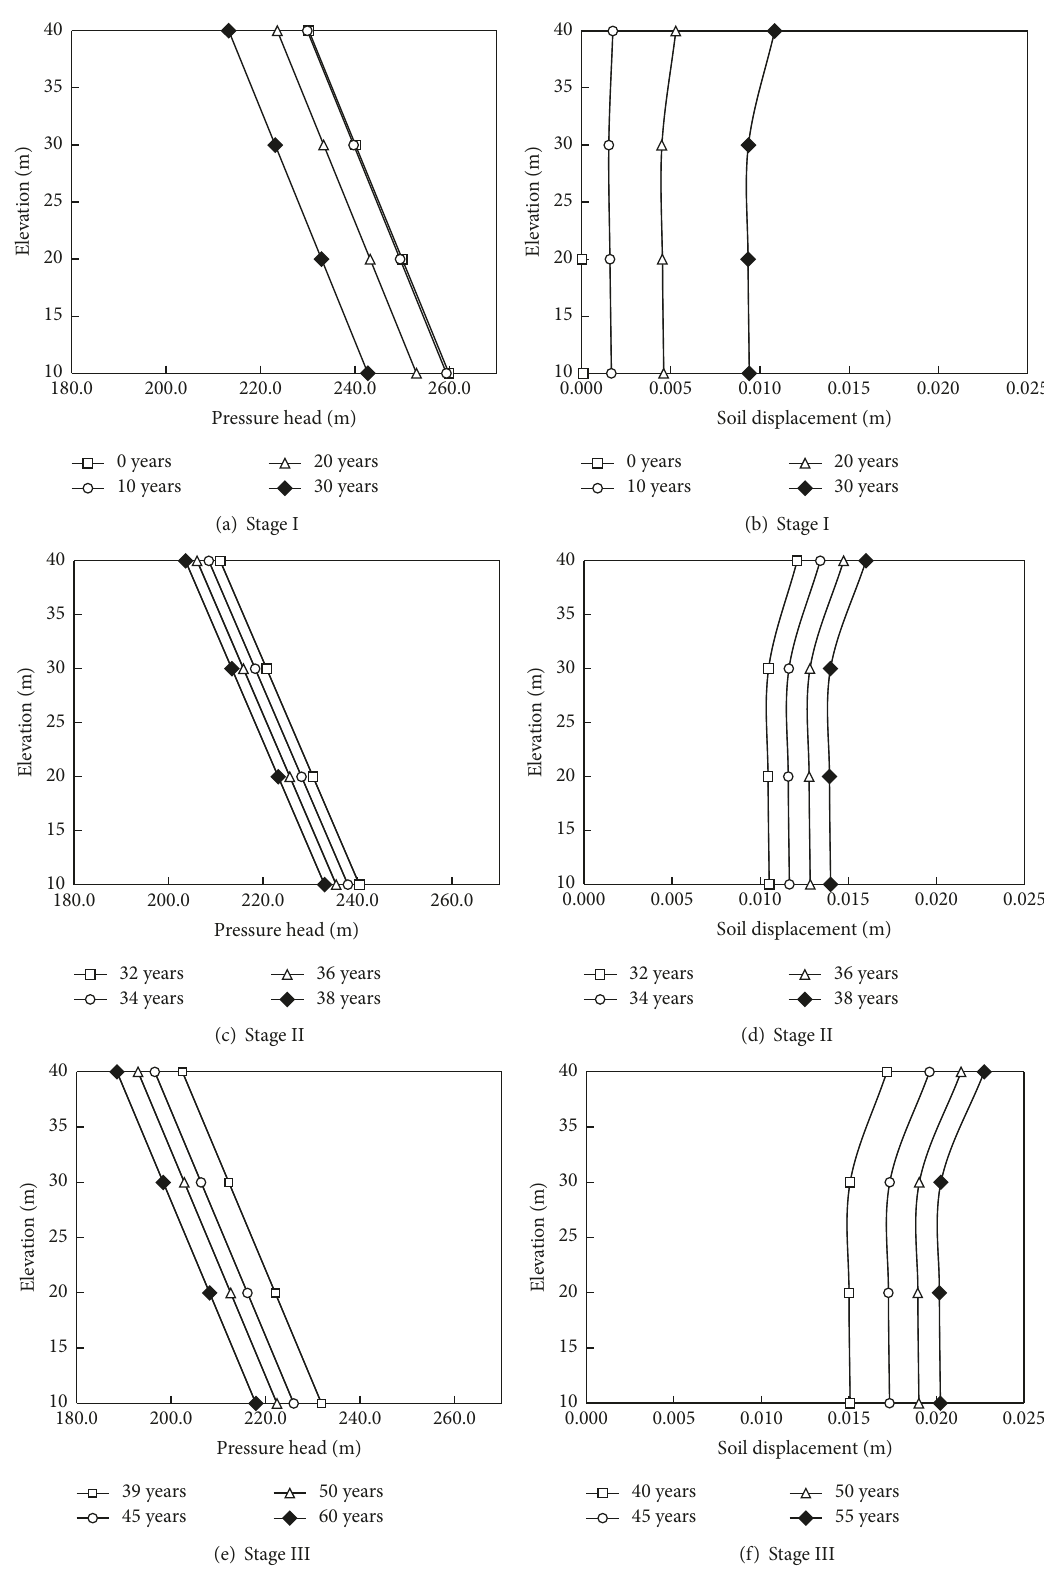
Figure 8: Distributions of pressure head and soil displacement in confined aquifer III during different